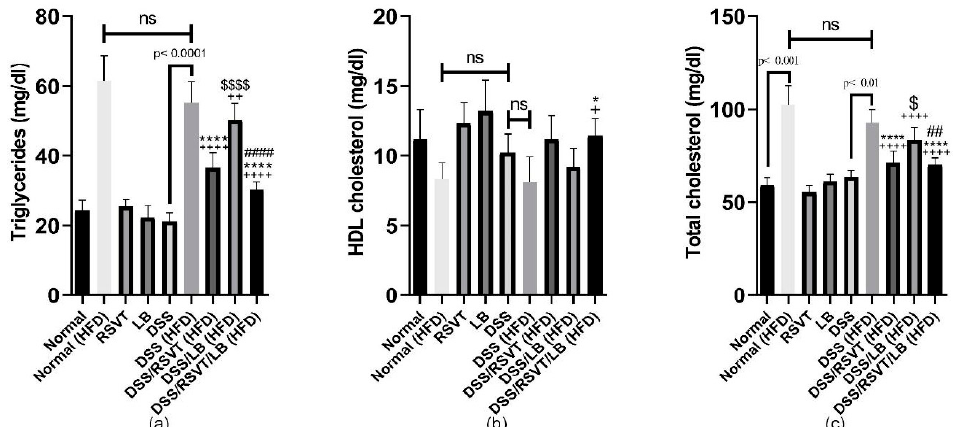
Figure 10. Effect of rosuvastatin (RSVT), Lactobacillus (LB), and their combined therapy on ( a ), triglycerides; ( b ), high density lipoprotein (HDL); and ( c ), total cholesterol. +, p < 0.05 vs. Normal (HFD); ++, p < 0.01 vs. Normal (HFD); ++++, p < 0.0001 vs. Normal (HFD); *, p < 0.05 vs. DSS (HFD); ****, p < 0.0001 vs. DSS (HFD); ##, p < 0.01 vs. DSS/LB (HFD); ####, p < 0.0001 vs. DSS/LB (HFD); $, p < 0.05 DSS/RSVT (HFD) vs. DSS/LB (HFD); $$$$, p < 0.0001 DSS/RSVT (HFD) vs. DSS/LB (HFD); ns, non-significant.